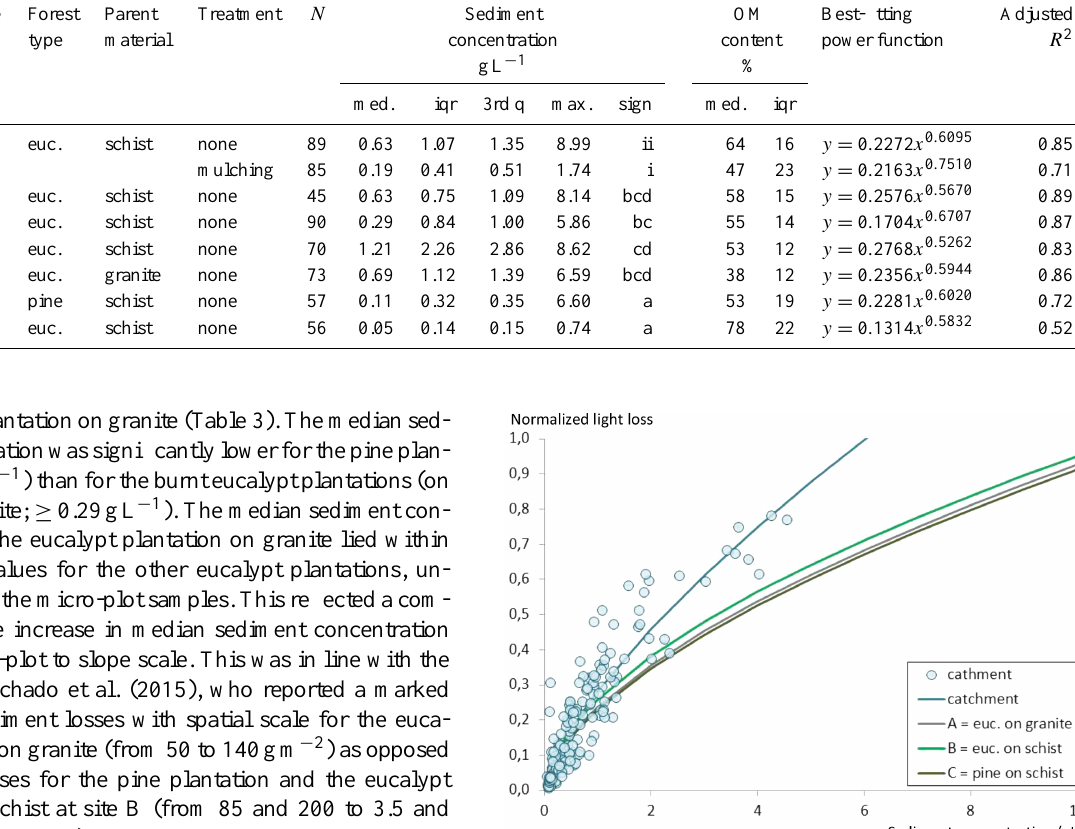
Table 3. Sediment concentrations and corresponding organic matter (OM) contents of the slope-scale overland flow samples at the seven study sites and best-fitting power functions between sediment concentration ( x ; ingL − 1 ) with normalized light loss ( y ). Euc.: eucalypt; med.: median; iqr: inter-quartile range; 3rd q: third quartile; max.: maximum; sign: statistically significant differences, at α = 0.05, are indicated by different roman numbers in the case of the treatments tested at the S site and by different letters in the case of the other sites.